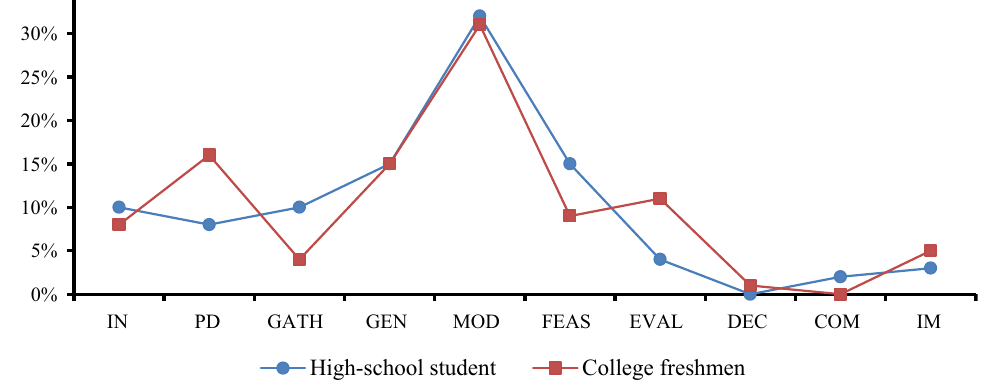
Fig. 5 The frequency of engineering design behavior of the two